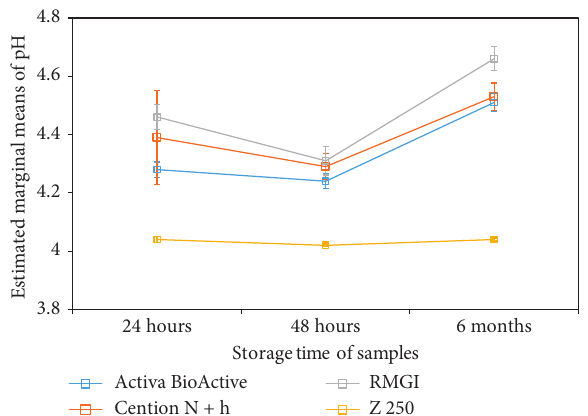
Figure 3: Mean changes in pH value after acidification of the medium (pH � 4) and placing samples (24 hours, 48 hours, and 6 months) in it for 60 minutes.